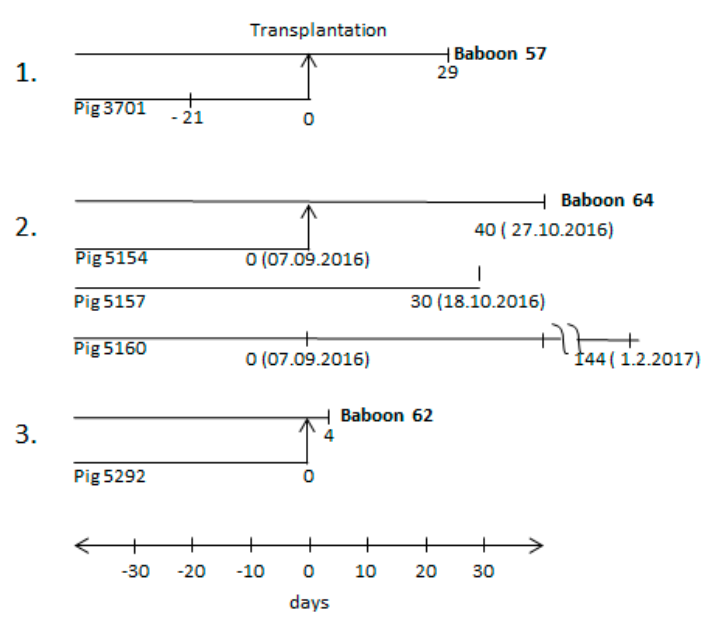
Figure 1. Time schedules of three different transplantation experiments (numbers 1–3) and animals involved. The arrows from the line of the donor pig (3701, 5154, 5292) to the line of the recipient baboon (57, 64, 62) indicate the day of transplantation (day 0); other time points before and after transplantation indicate the time of bleeding. The bleeding times of sibling pigs 5157 and 5169 are also indicated.